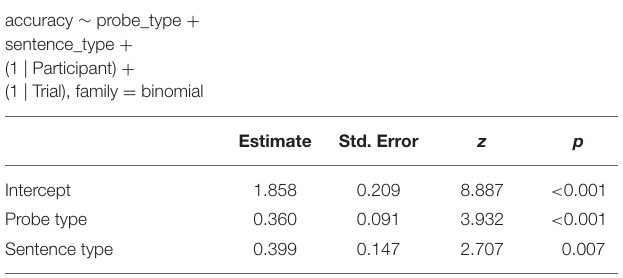
TABLE 4 | The specification and parameter estimates of the best fitting model predicting accuracy in the Different probe conditions in Experiment 2. accuracy ∼ probe_type + sentence_type